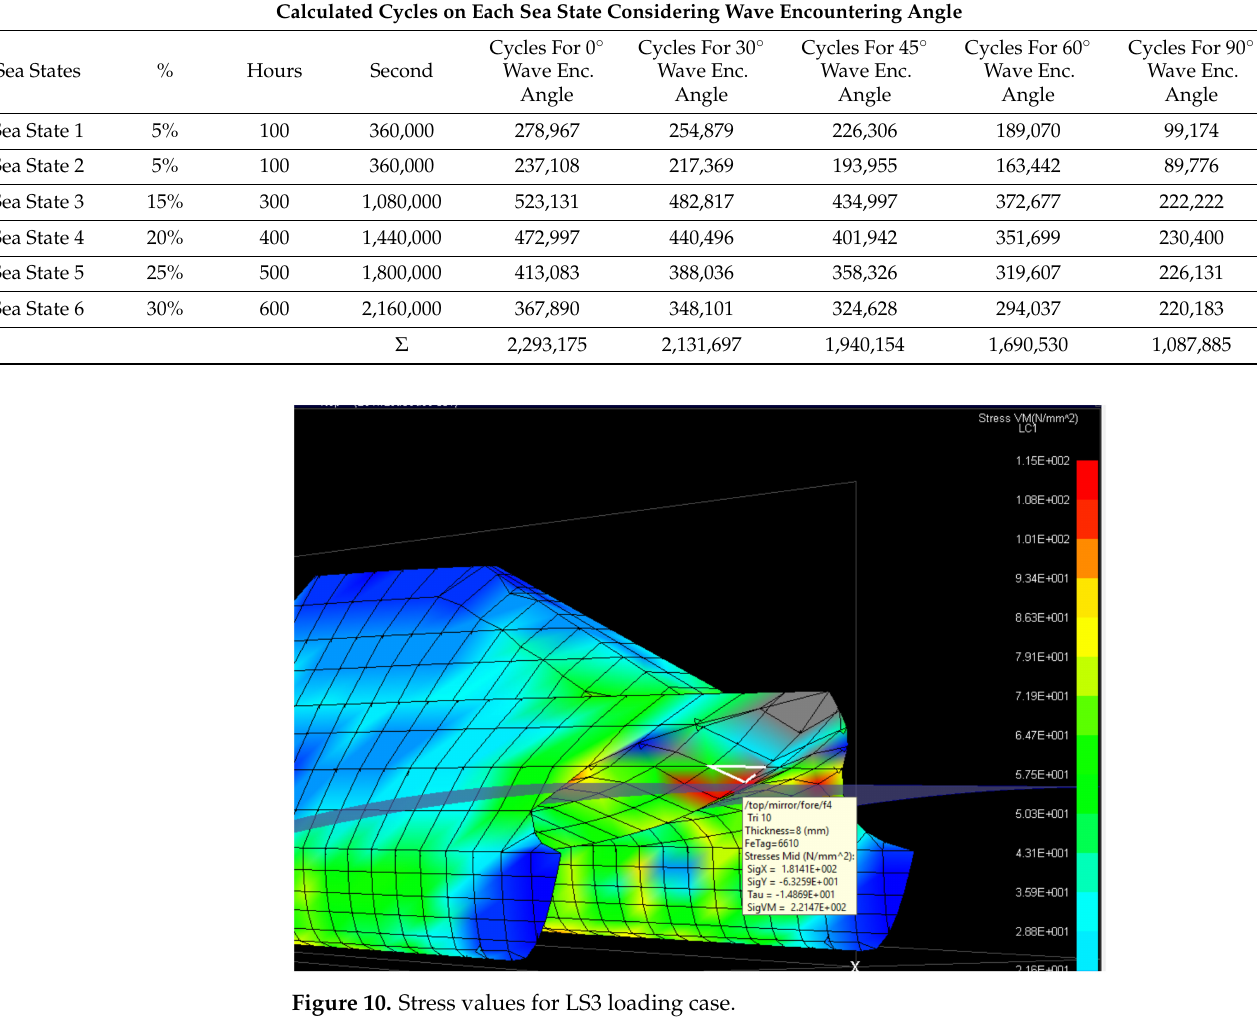
Table 12. Encounter cycle vs. sea state summary.